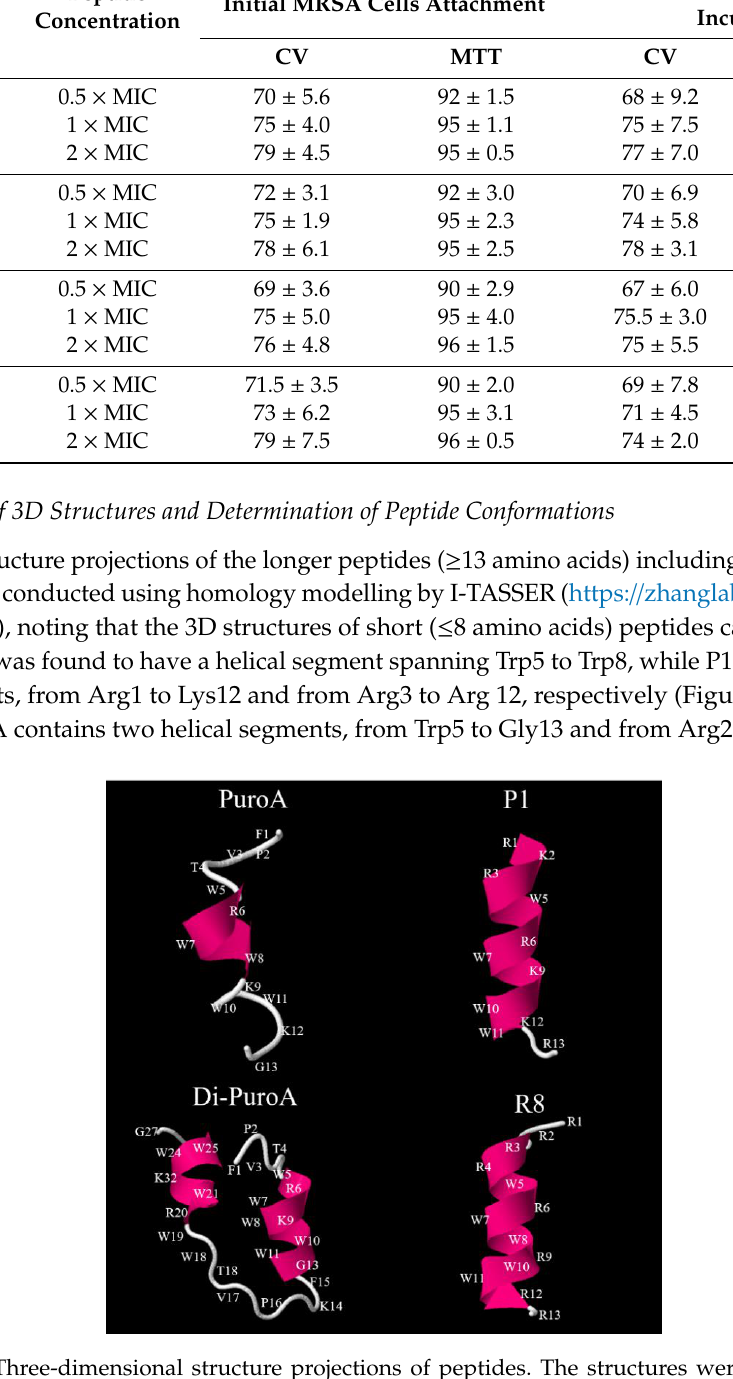
Figure 2. Three-dimensional structure projections of peptides. The structures were predicted by I-TASSER (http://zhanglab.ccmb.med. umich.edu/I-TASSER).